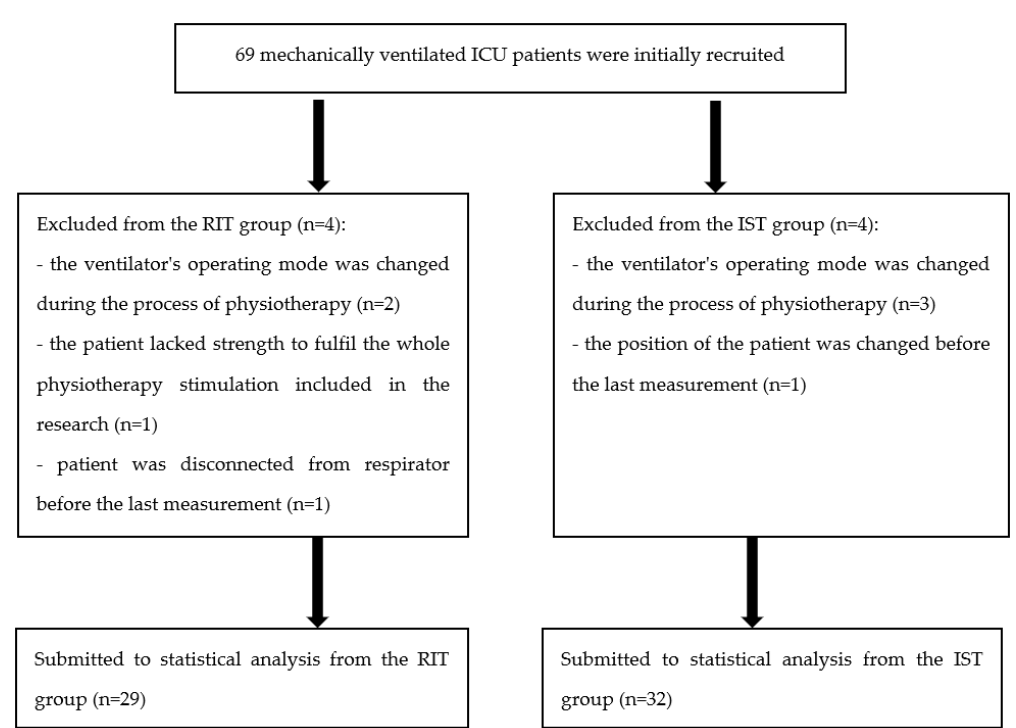
Figure 1. Flow chart of the study. RIT = rhythmic initiation technique, IST = initial stretch tech ‐ nique.